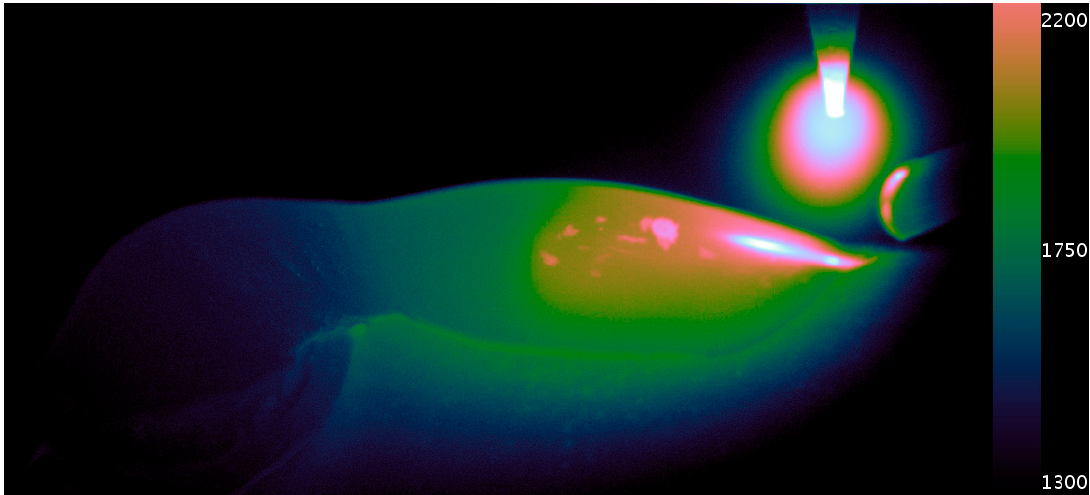
Figure 5. An example frame from the thermal video (scale in °C) with the Cube Helix color map applied. Slag floating on the molten weld can be seen in the center of the image, giving an indication of the weld pools dynamics. The heat transfer into the workpiece and the cooling regions of solidified weld can also be seen towards the bottom left of the image .